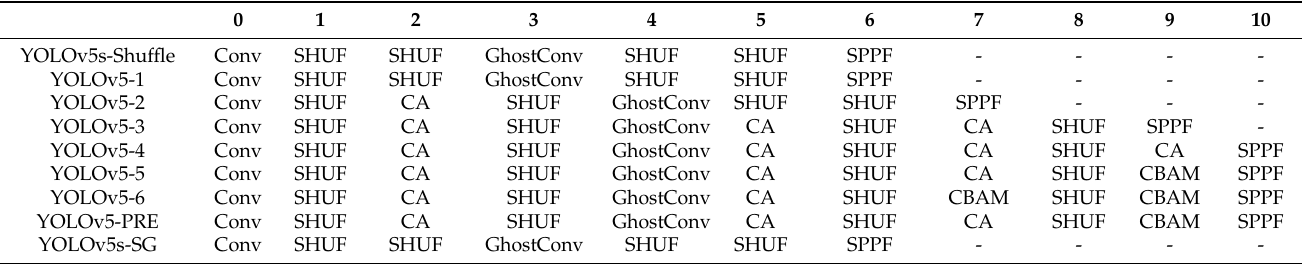
Table 2. Algorithm Backbone structure.